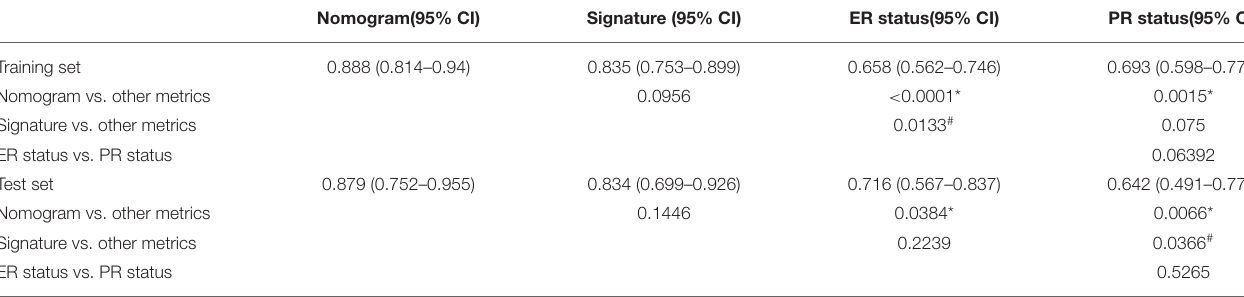
TABLE 4 | AUCs of Nomogram, radiomics Signature, ER status, and PR status for pCR prediction in Trarining and Test